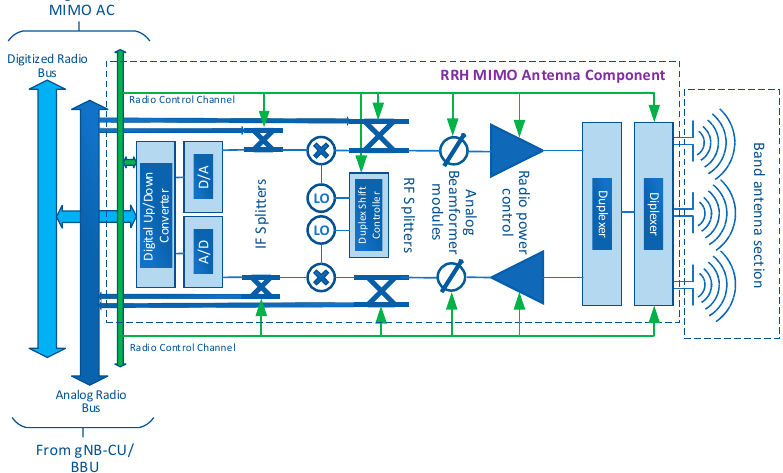
Figure 4. Massive-MIMO antenna component of optical gNB-DU / RRH—example of single radio-antenna module. Proposition of gNB-DU / RRH construction with components controlled in SDR mode by the radio control channel (green line) (presented in proceedings